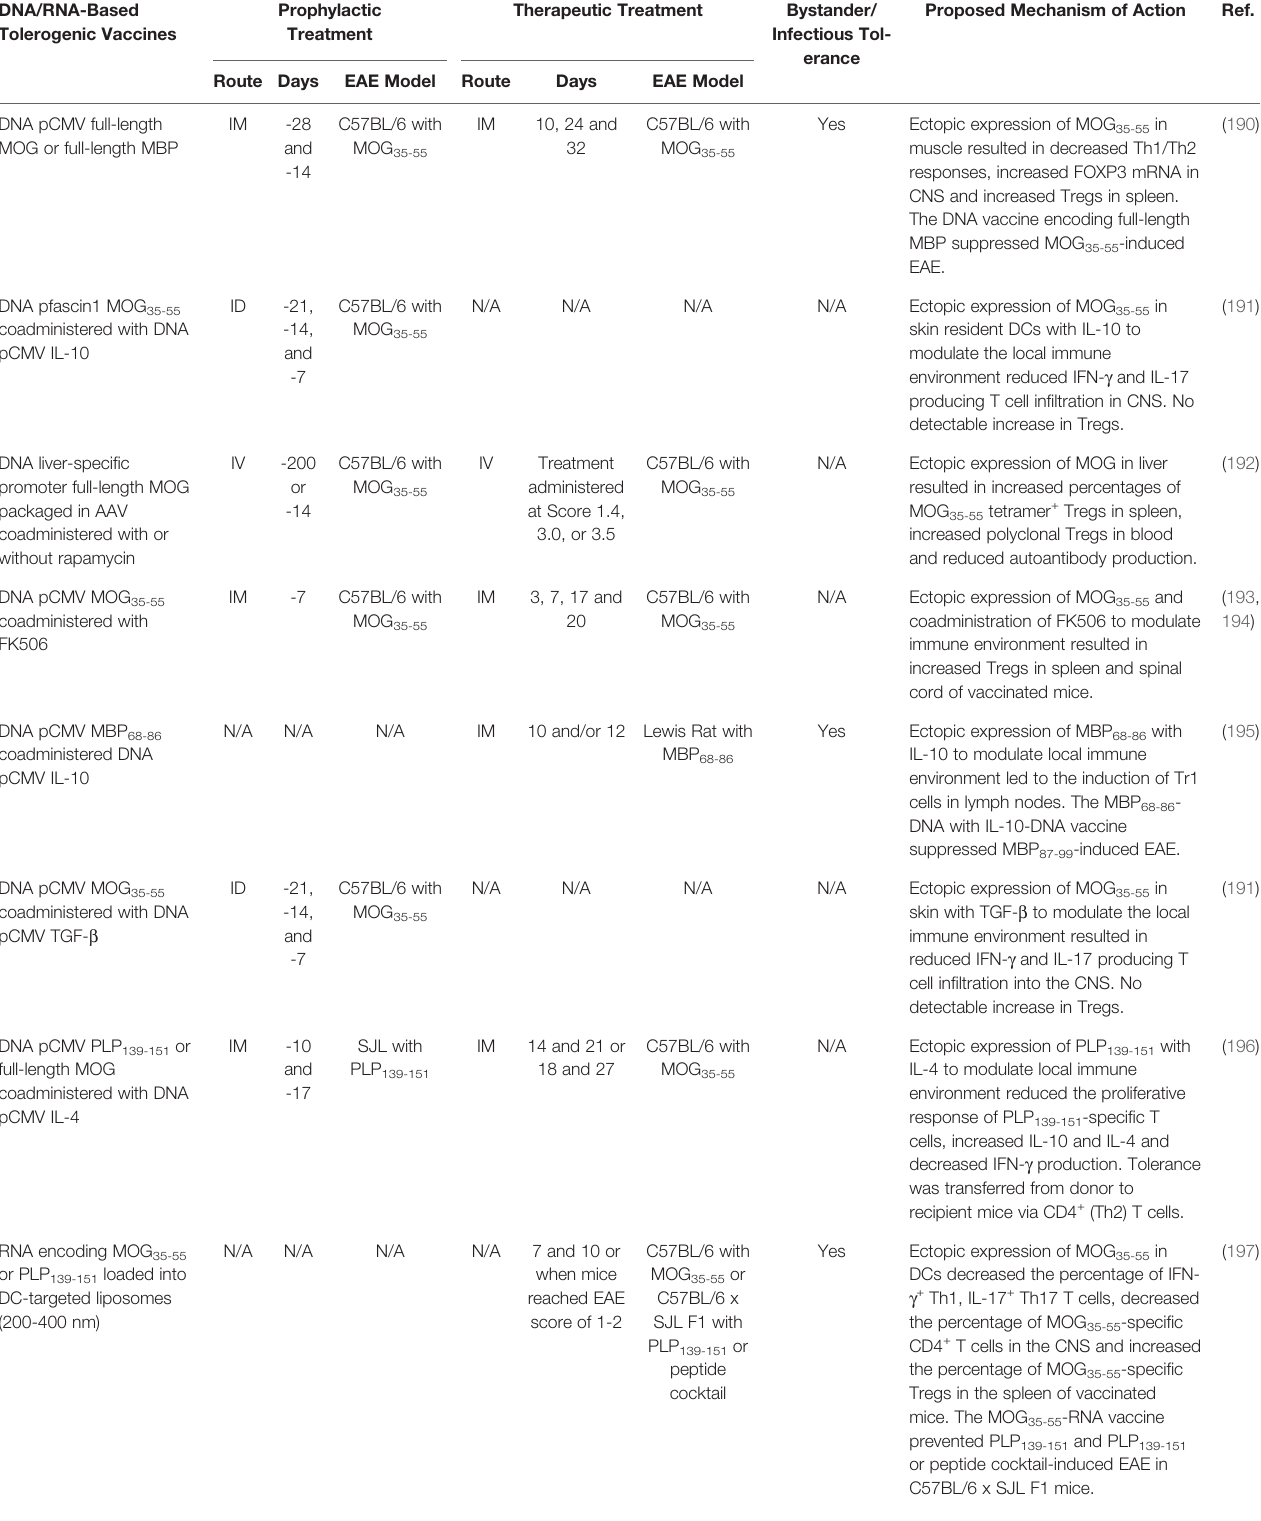
TABLE 4 | DNA-based tolerogenic vaccines. DNA/RNA-Based Tolerogenic